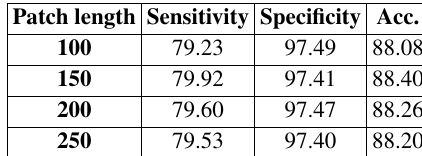
Table 3. CD results for the Bay Area scene using proposed method as the patch length is varied.